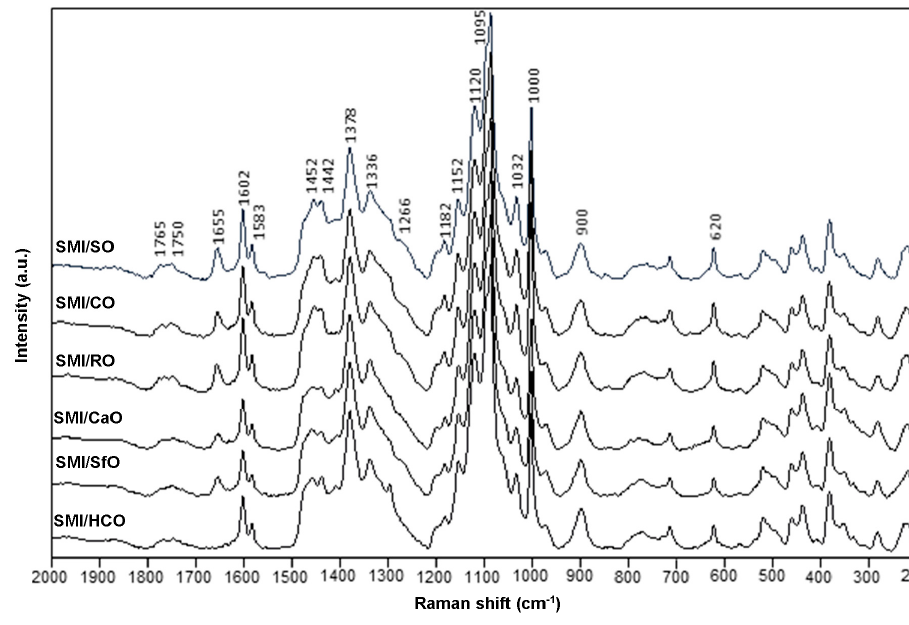
Figure 3. Raman spectra for SMI/oil coatings on paper.